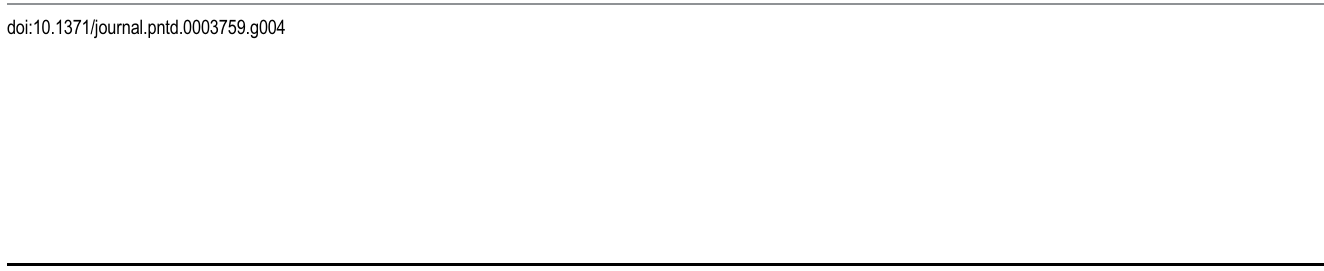
Fig 4. Time evolution of instantaneous Δ G eff values for FhCL3 complexes. Effective binding free energies (green) are shown together with accumulated mean values (black). Dashed lines indicate the MD equilibration time of FhCL3 complexes. Every complex was labeled with the corresponding compound